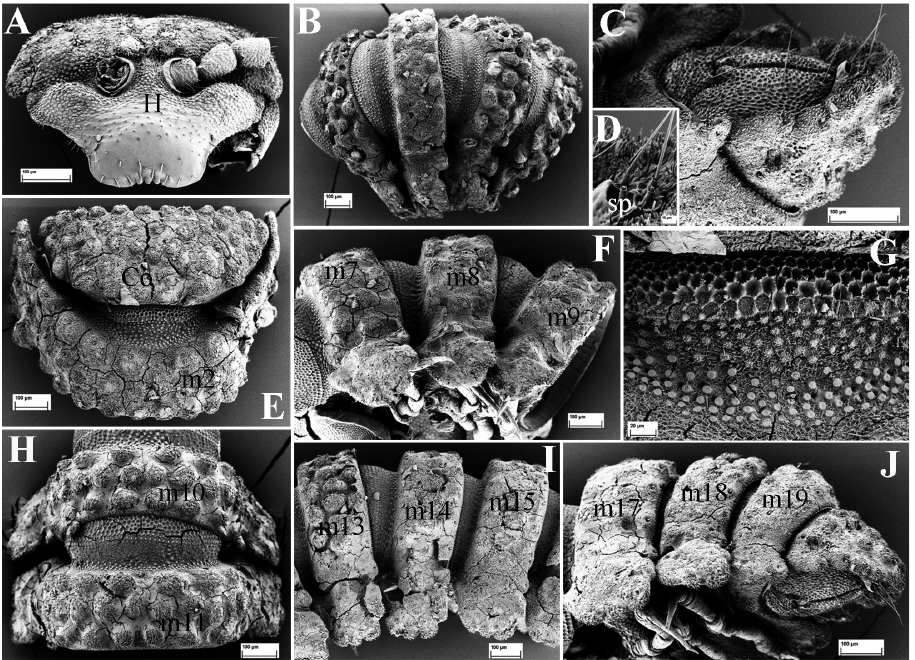
Figure 11. E. parvus sp. n., SEM, male paratype from Cave Tham Nam Long. A head (H), frontal view B segments 3–6, subdorsal view C telson, subventral view D spinneret (sp), detail E collum (Co) and segment 2 (m2 = metatergum 2), dorsal view F segments 7–9, lateral view (m7–m9 = metaterga 7–9) G prozonum 2, dorsal view H segments 10–11, dorsal view I segments 13–15, dorsal view J segments 17–19 and telson, lateral view (m10–11, 13–15, 17–19 = metaterga 10, 11, 13–15,